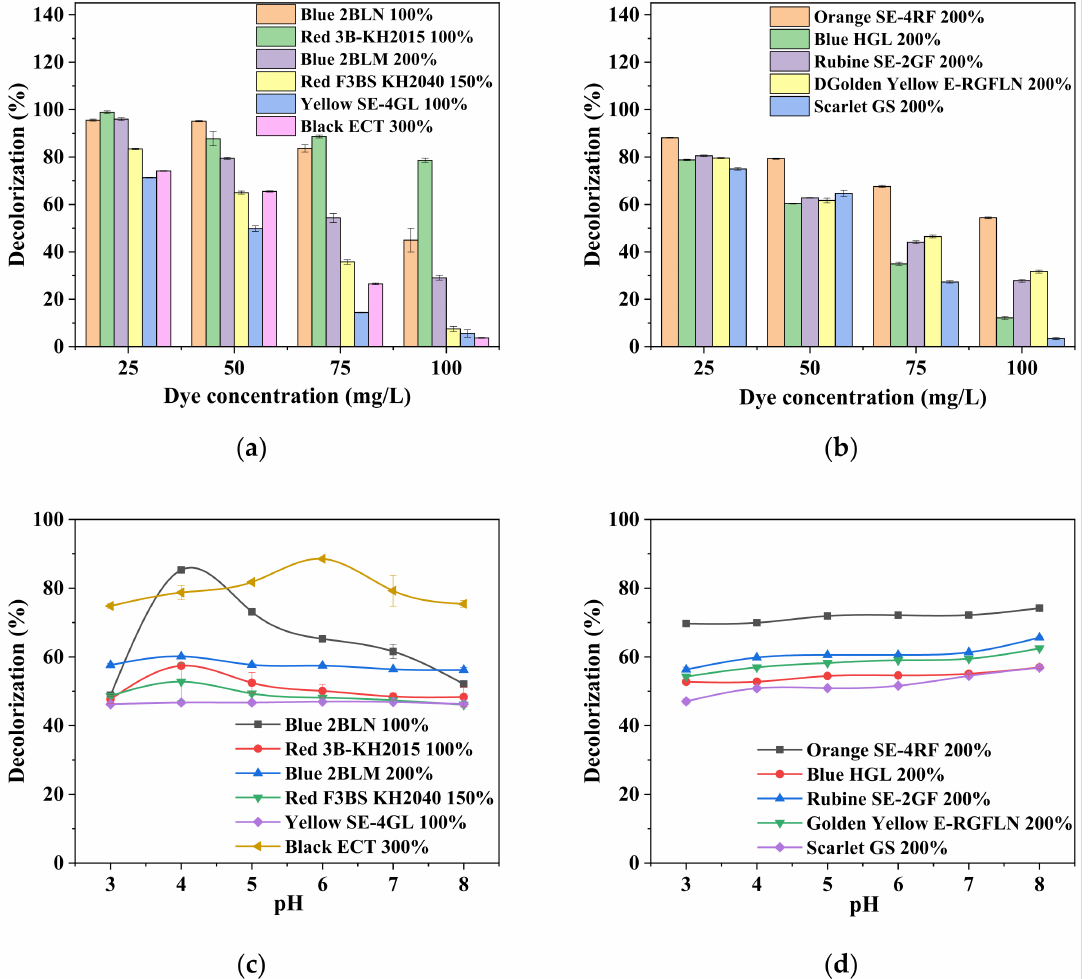
Figure 3. Effect of initial dye concentration ( a , b ) and pH value ( c , d ) on decolorization rate of 11 disperse dyes with other parameters at optimal conditions, as listed in Table